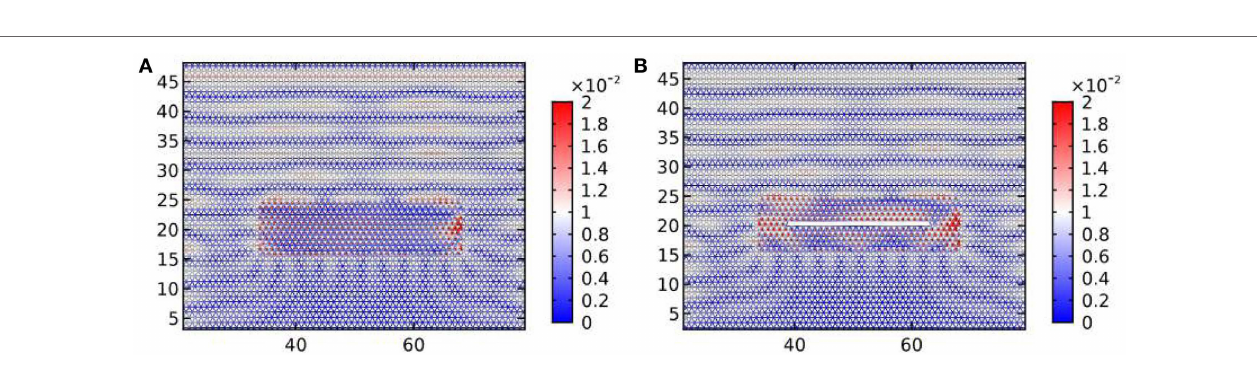
cluster. It is worthwhile noting that if the resonators are rotated in the anticlockwise direction ( ϑ 0 = (cid:0) 0.82), the displacement field is mirror-symmetric compared to the one in Figure 8A